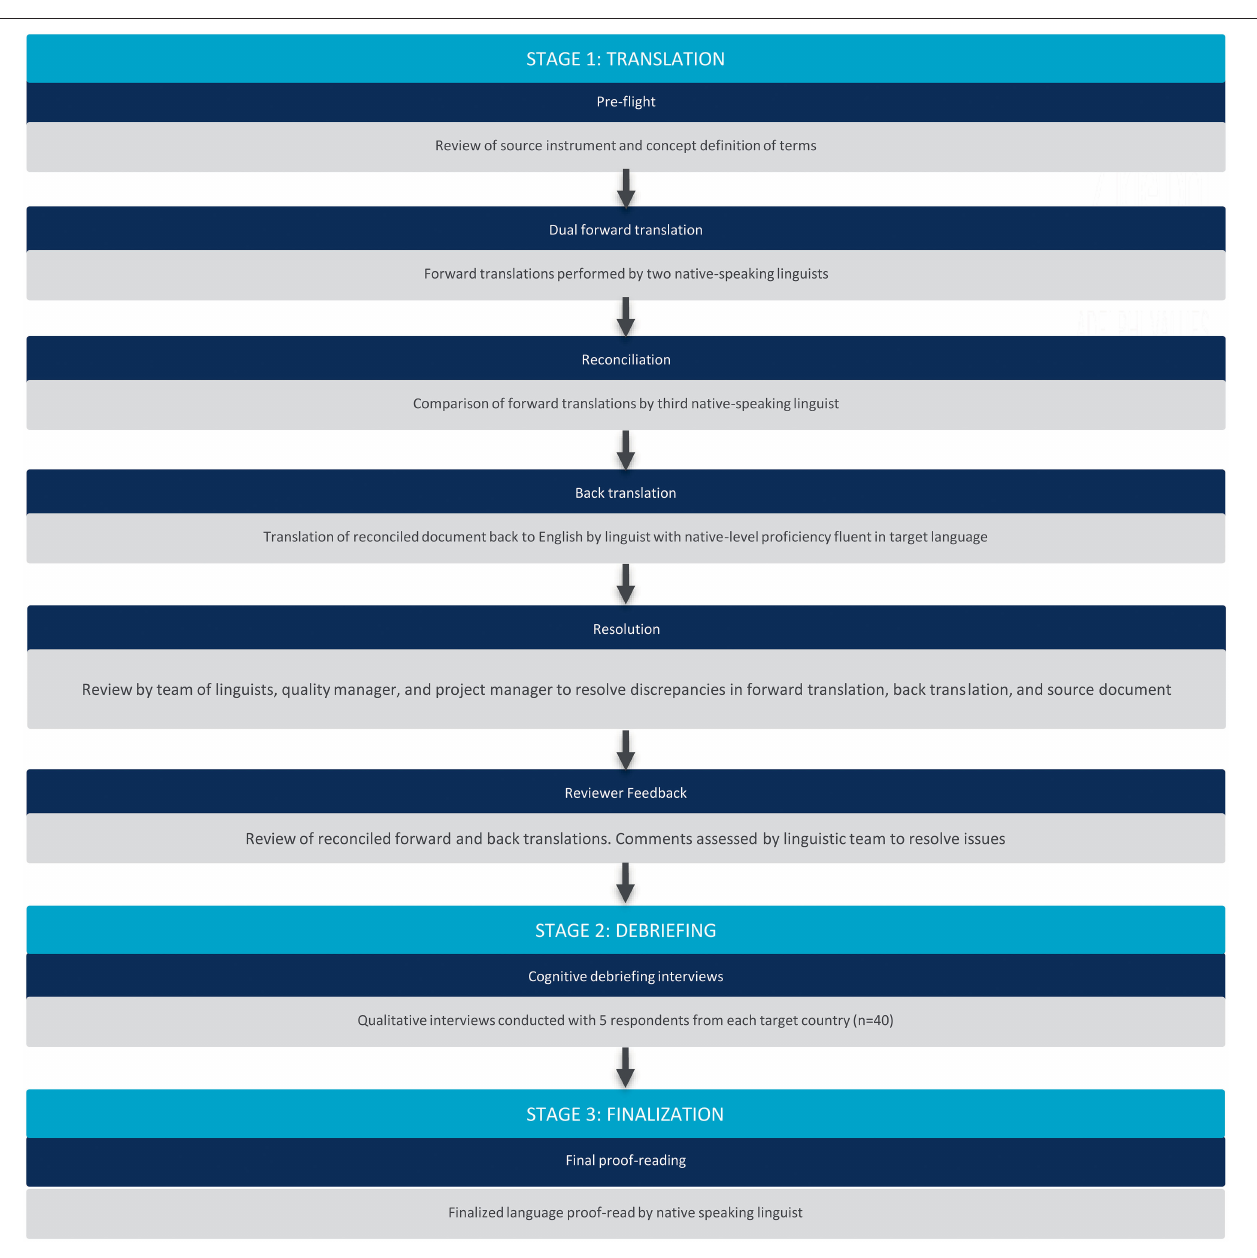
FIGURE 1 | Translation and linguistic validation